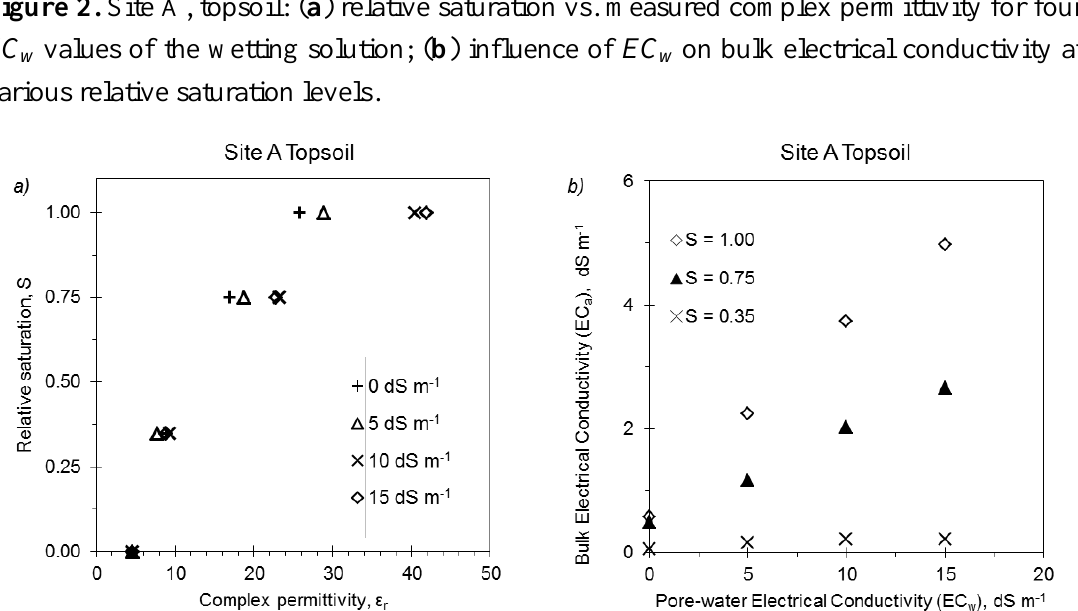
on bulk electrical conductivity at w